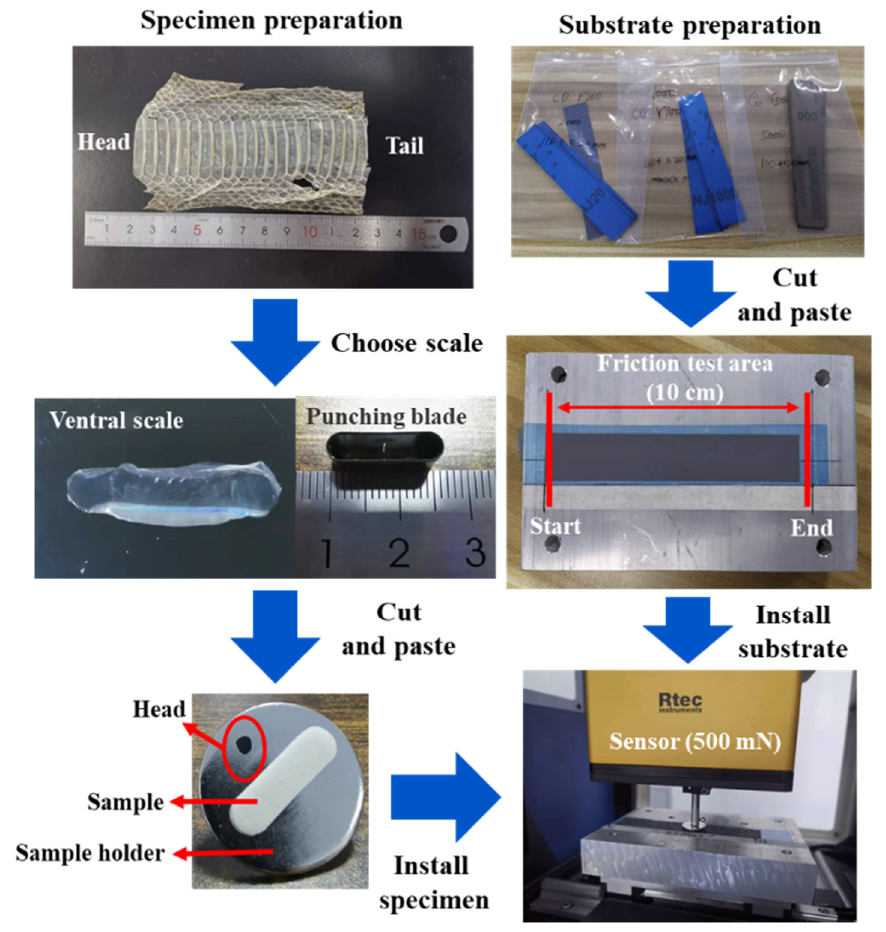
Figure 2. Schematic diagram of the process of specimen and substrate